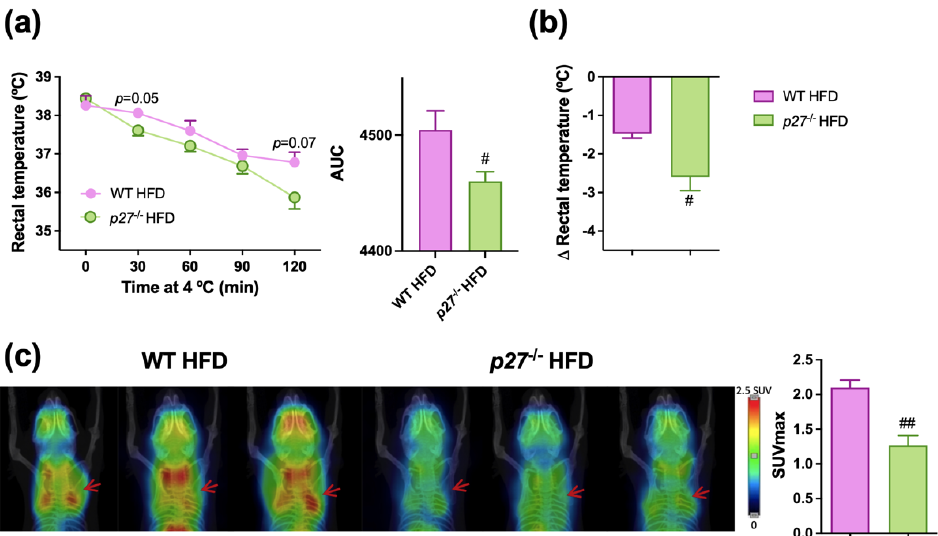
Figure 5. p27 -/- HFD mice exhibit lower iBAT activity and impaired response to cold exposure. ( a , b ) Rectal temperature measured at different timepoints during cold exposure to 4 °C including AUC (area under the curve) ( a ) and changes in rectal temperature before and after 2 h of cold exposure ( b ) in WT and p27 -/- mice fed with HFD for 10 weeks ( n = 5–10). ( c ) 18 F-FDG uptake in iBAT using microPET 1 h after 18 F-FDG injection in WT and p27 -/- male mice fed with HFD for 10 weeks and pre-exposed for 1 h at 4 °C. Left panel: representative microPET coronal slices of the iBAT area (red arrow) co-registered with a CT 3D image of another animal used as anatomical reference. Right panel: maximum standardized uptake value (SUVmax) ( n = 3). Data are expressed as mean ± SEM. # p < 0.05, ## p < 0.01, vs. WT HFD.